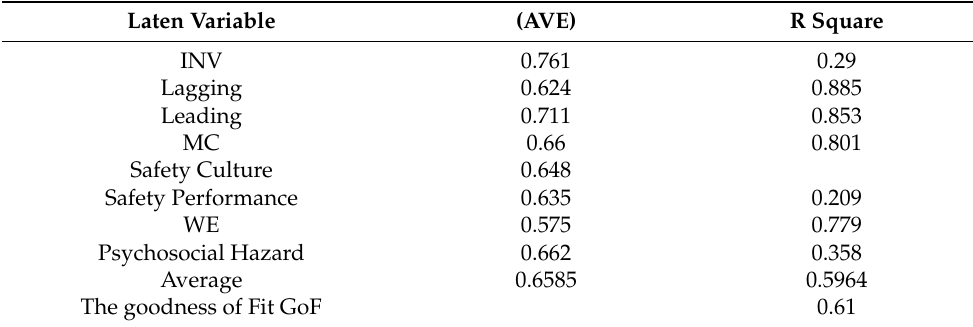
Table 4. Model of GoF.